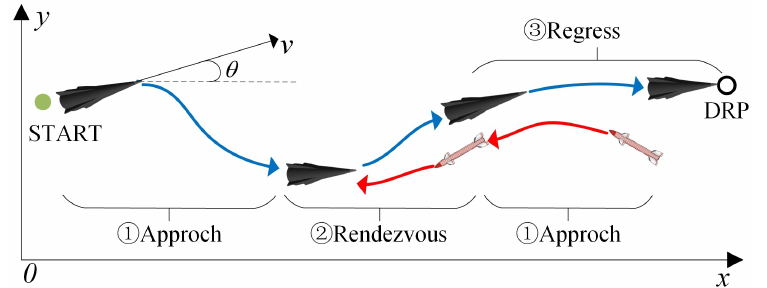
Figure 1. Illustration of an HGV anti-interception manoeuvre. The anti-interception of an HGV can be divided into three phases. 1 (cid:13) Approach. The HGV manoeuvres according to anti-interception guidance, while the interceptor operates under its own guidance. Since the HGV is located a long distance from the interceptor, and has high energy, various penetration strategies are available during this phase. 2 (cid:13) Endezvous. At this phase, the distance between the HGV and the interceptors is the shortest. This distance may be shorter than the kill radius of the interceptors, allowing for the HGV to be intercepted, or greater than the kill radius, allowing for the HGV to successfully avoid interception. 3 (cid:13) Egress. With its remaining energy, the HGV flies to the DRP after moving away from the interceptors. A successful mission requires the HGV to arrive at the DRP with the highest levels of energy and accuracy. From the above analysis, it can be seen that whether the HGV can evade the interceptors in phase 2 (cid:13) depends on the manoeuvres adopted in phase 1 (cid:13) . Phase 1 (cid:13) also determines the difficulty of ballistic regression in phase 3 (cid:13)